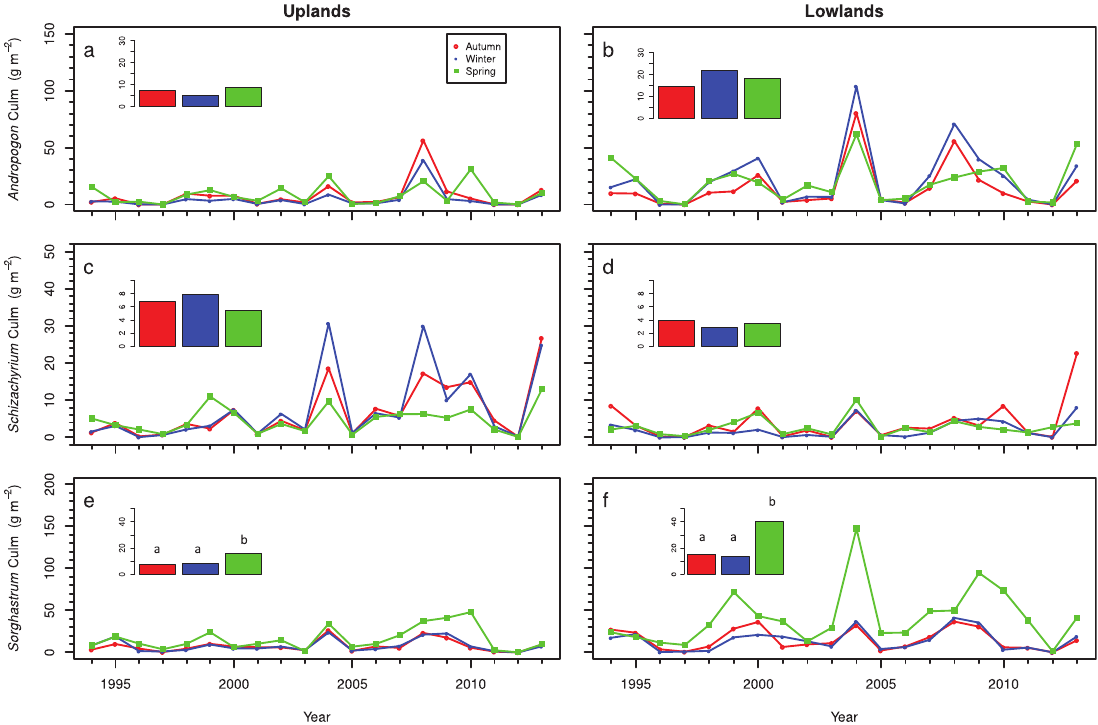
Figure 4. Changes in flowering culm production for (a,b) Andropogongerardii , (c,d) Schizachyriumscoparium , and (e,f) Sorghastrum nutans from 1994–2013 for uplands (a,c,e) and lowlands (b,d,f) in autumn-, winter-, and spring-burned watersheds.